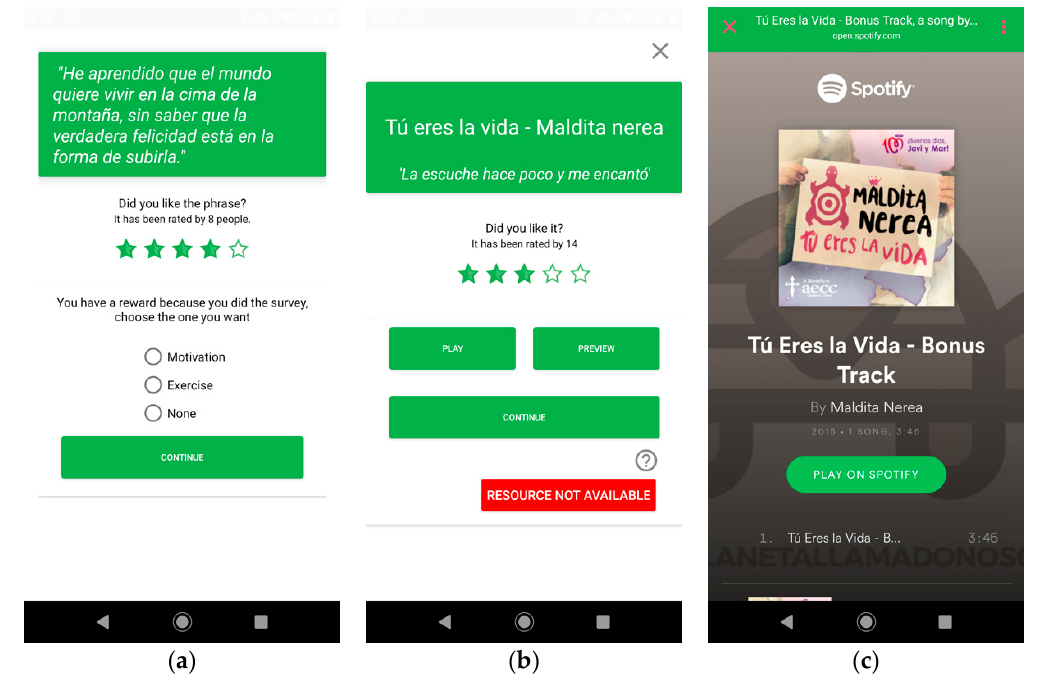
Figure 2. Screens of the user interface: ( a ) Reward after completing a survey, ( b ) Motivation reward and ( c ) Reward